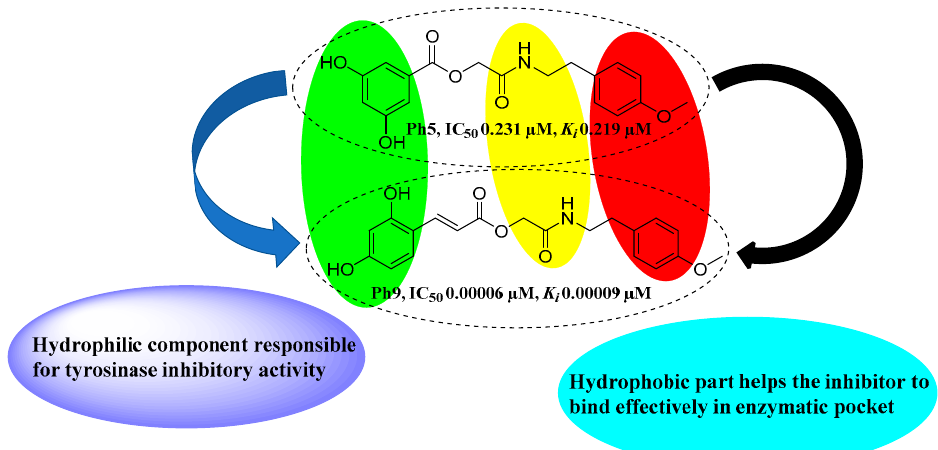
Figure 5. Structure–activity relationship (SAR) for the synthesized compounds (Ph1–Ph10), promising compounds from both series (Ph1–Ph5 and Ph6–Ph10) are represented. Ph1: 2-((4-methoxy-